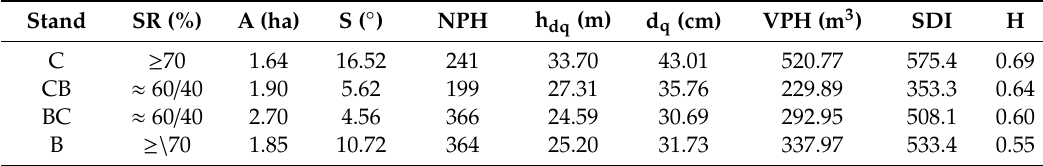
Table 1. Forest stand characteristics across reference